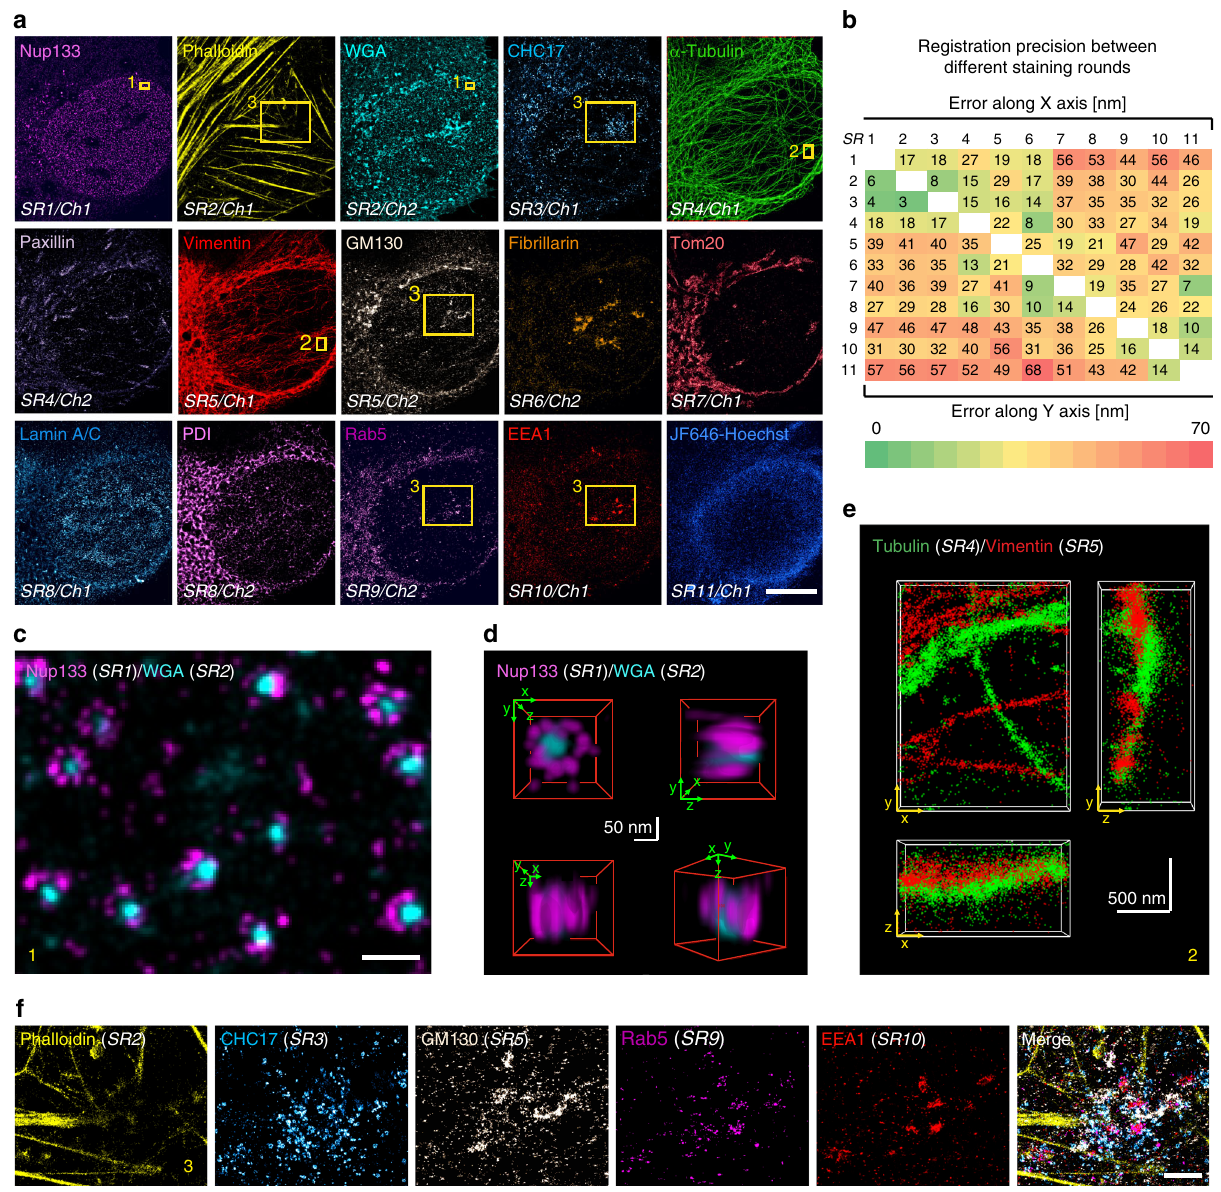
Fig. 2 Multi-target 3D dSTORM of a single U2OS cell. a A U2OS cell with 15 targets labeled and acquired by 11 staining rounds (SR). Two channels (Ch) can be detected per SR, but not always each channel can be used for fi nal analysis. In addition, to get optimal signal for some sensitive labels (e.g., GFP nanobodies against the Ypet-tag of Nup133), it was bene fi cial to not stain targets in the second channel (see Supplementary Note 2). Boxes denote regions magni fi ed in c , e , and f . Another three experiments were carried out with similar designs and outcomes. Further details see Methods section. b Heatmap representing the registration error along the x (upper matrix part) and the y axis (lower matrix part) reveals precise registration, in particular, between images of adjacent staining rounds (arranged along the white diagonal fi elds). c Magni fi ed view of boxed region 1 in a with merged peripheral Nup133 and central WGA nuclear pore labeling demonstrating that super-resolution images from consecutive SRs can be registered with high precision. d 3D views of a nuclear pore complex (from the multiplex experiment in a ) demonstrate the high lateral and axial resolution and registration precision. e Merged tubulin and vimentin 3D images from consecutive SRs, demonstrating that super-resolution images can be acquired and registered in 3D (boxed region 2 in a ). f Five-color merge of boxed region 3 in a : phalloidin-labeled actin fi laments, CHC17-labeled clathrin-coated structures, GM130-labeled proximal Golgi apparatus, endosome-associated proteins Rab5 and EEA1. Scale bars correspond to 10 µ m in a , 200 nm in c , 50 nm in d , 500 nm in e , and 2 µ m in f